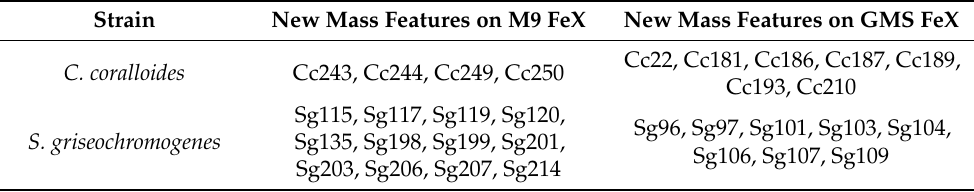
Figure 2. Number of new mass features in extracts of minimal media experiments, limitation experiments, and unbaffled flask experiments (all other experiments were conducted in baffled flasks). The ‘-’ indicates that the condition was not tested with this bacterium; a ‘0’ refers to no new mass features; and in the conditions marked with ‘ng’, bacteria did not grow. Every OSMAC condition was tested twice. The new mass feature had to be present in both biological duplicates. The mass feature signal had to surpass an intensity of 10 5 [a.u.] to be considered for the number of new mass features. Therefore, this diagram only shows the number of reproducibly detected mass features in the duplicate cultivation. Table 5. Comparison of new mass features produced by C. coralloides and S. griseochromogenes on M9 FeX medium and GMS FeX medium. The mass features’ properties ( m/z and t R ) can be found in the Supplementary